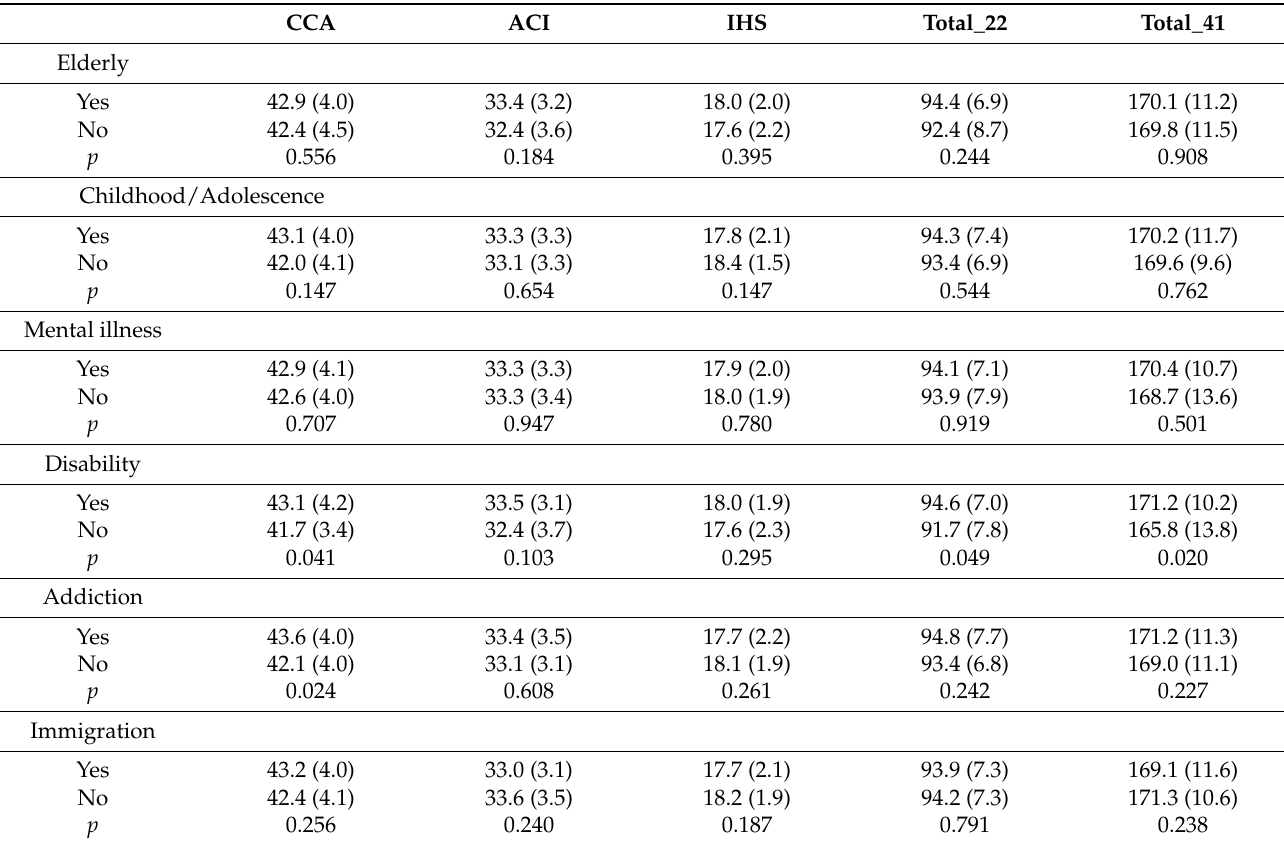
Table 4. Association between working experience with various groups of users and social workers’ empathy—mean scores (SDs). CCA ACI